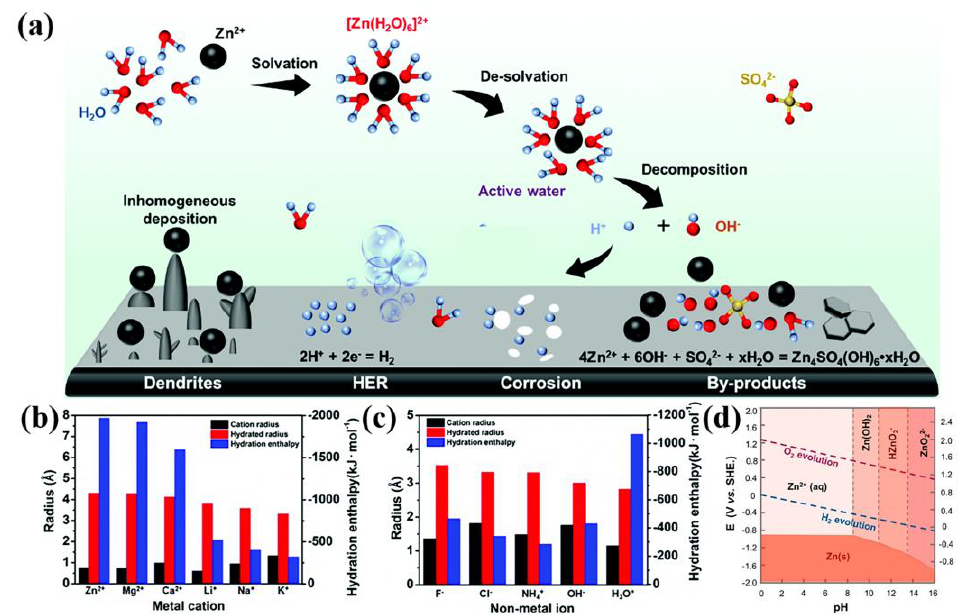
Figure 1. ( a ) Schematic illustration of the zinc ion deposition process. Adapted with permission from Ref. [47]. Copyright 2022 Energy & Environmental Science. Comparison of the ionic radius, hydrated radius, and hydration enthalpy of ( b ) metal cation charge carriers and ( c ) non-metal charge carriers. Adapted with permission from Ref. [46]. Copyright 2022 Energy & Environmental Science.